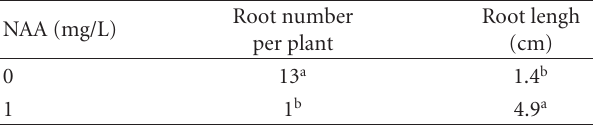
Table 2: Influence of NAA on rooting after 4 weeks. NAA (mg/L)